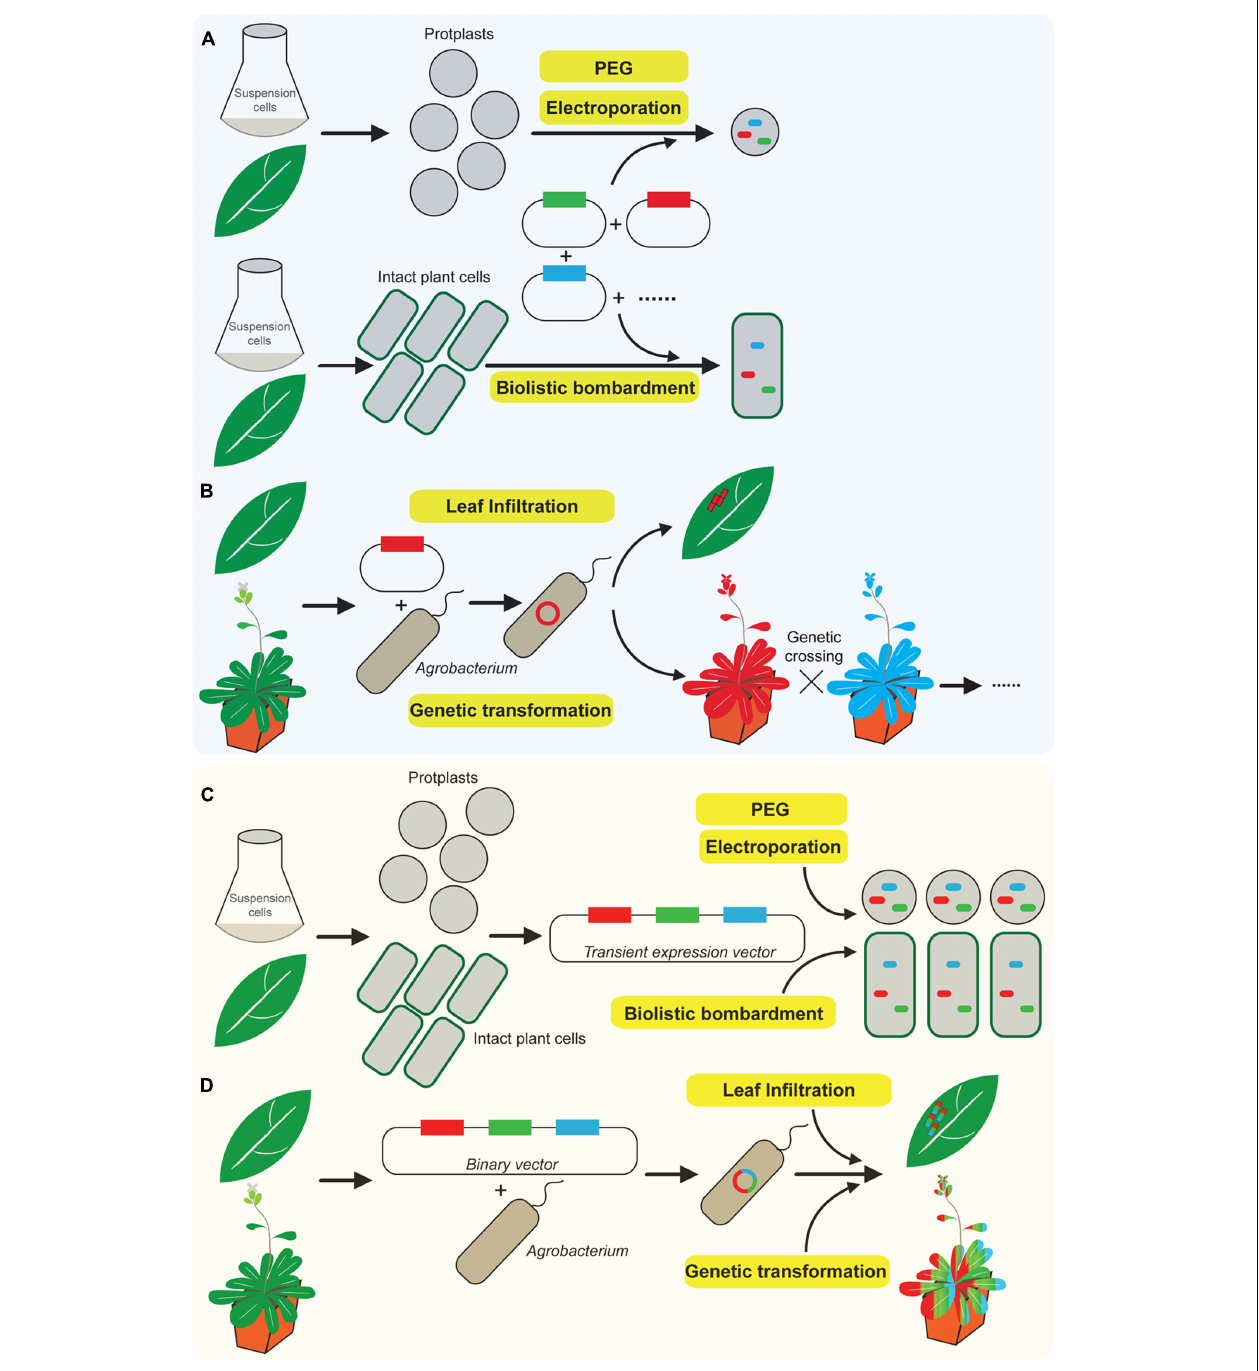
FIGURE 1 | A novel robust system for co-expression of multiple chimeric fluorescent fusion proteins in plants. (A) Conventional approaches of co-expression of multiple chimeric fluorescent fusion proteins in plants via transient expression including biolistic bombardment, electroporation, and polyethylene glycol (PEG)-mediated transformation require mixture of several individual plasmids, which dramatically reduce the efficiency of protein co-expression. (B) Classical method of Agrobacterium mediated either leaf infiltration or stable genetic transformation, the binary vector is usually designed to express a single fluorescent fusion protein at one time. Multiple protein co-expression requires further genetic crossing of individual stable single expression plant. (C) Overview of the newly developed novel multiple protein co-expression system. Transient co-expression of multiple chimeric fluorescent fusion proteins via a single transient expression vector in intact plant cells or protoplasts derived from suspension-cultured cells or plant leaves. This was performed either by biolistic bombardment, electroporation or PEG-mediated transformation. In addition, Agrobacterium mediated transient expression via tobacco leaf infiltration or stable genetic transformation to express multiple chimeric fluorescent fusion proteins can be achieved via a single binary vector (D)